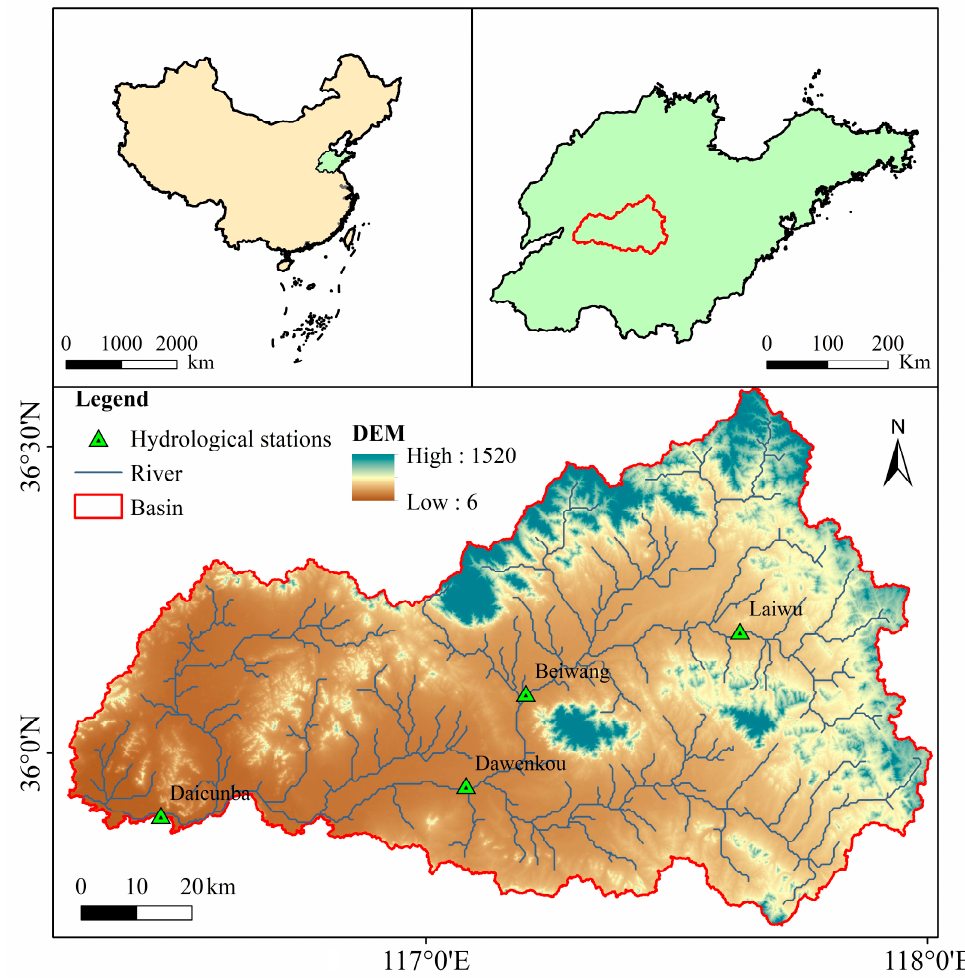
Figure 1. An overview map of the Daven River Basin.